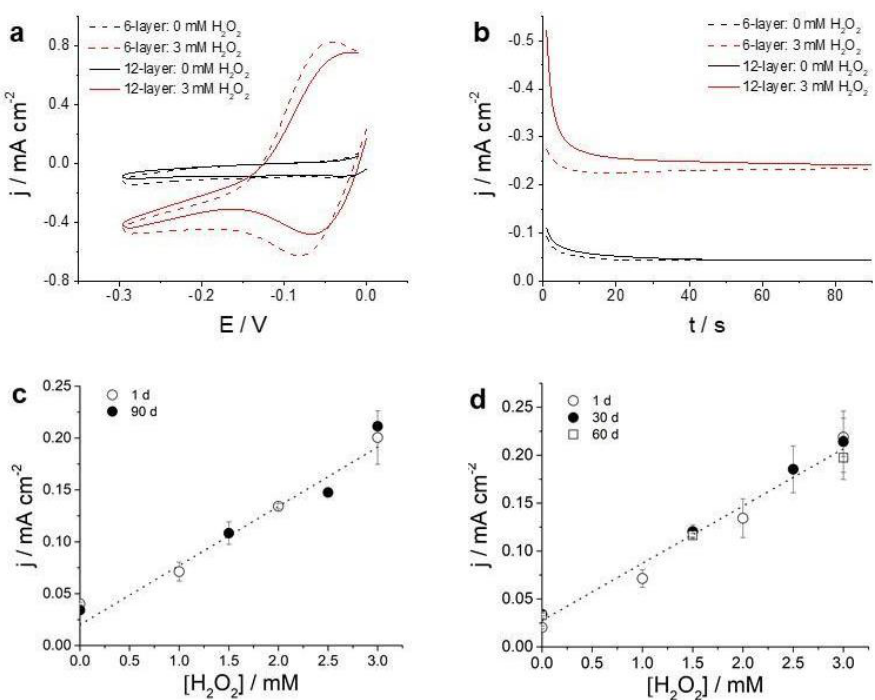
Figure 6. ( a ) CVs and ( b ) chronoamperometric curves for an applied potential of − 0.23 V obtained for a 6-layer (dotted lines) and 12-layer (solid lines) with printed SWCNT-SNP-HRP with a concentration of 5 mg/mL of SWCNT and 5 mg/mL of SNP-HRP, respectively, without and after the addition of H 2 O 2 to a final concentration of 3 mM in a solution of 4 mM hydroquinone in PBS of pH 7.4 at a scan rate of 0.05 V s −1 . ( c ) Dependence of current density on H 2 O 2 concentration for two SWCNT-SNP-HRP (6-layer with 5 mg/mL and 5 mg/mL concentration of SWCNT and SNP-HRP, respectively) electrodes printed with 1 day (open circles) and 90 days (full circles) after ink preparation. Linear regression is shown as a dotted line. Current was measured by chronoamperometry at 60 s with an applied potential of − 0.23 V in 0.1 M phosphate buffer of pH 7.4 and 4 mM hydroquinone. ( d ) Dependence of current density on H 2 O 2 concentration for three SWCNT-SNP-HRP electrodes measured 1, 30 and 60 days after being prepared under same conditions as described for Figure 6c.